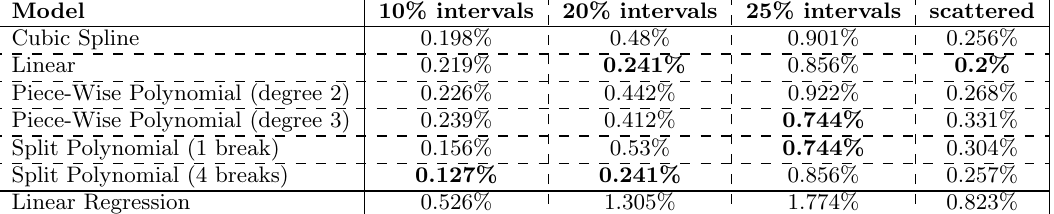
Table 2: Mean modeling errors for the power over load level function of the LU workload.